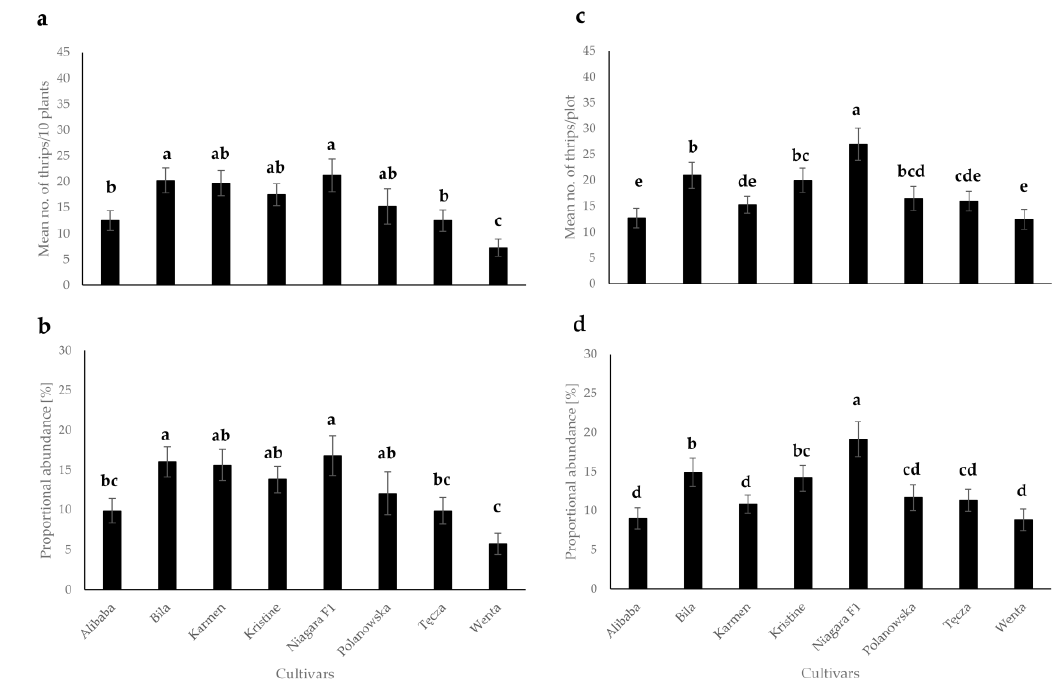
Figure 3. Actual count (mean ± SE) and proportional abundance of Thrips tabaci adults collected ( a , b ) directly from plants and ( c , d ) with sweep net during onion plant colonization by thrips in 2015. Means with the same letters on each bar are not significantly different (Duncan’s Multiple Range Test p < 0.05).